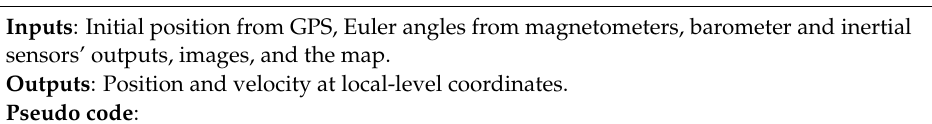
Algorithm 1. The integrated navigation algorithm